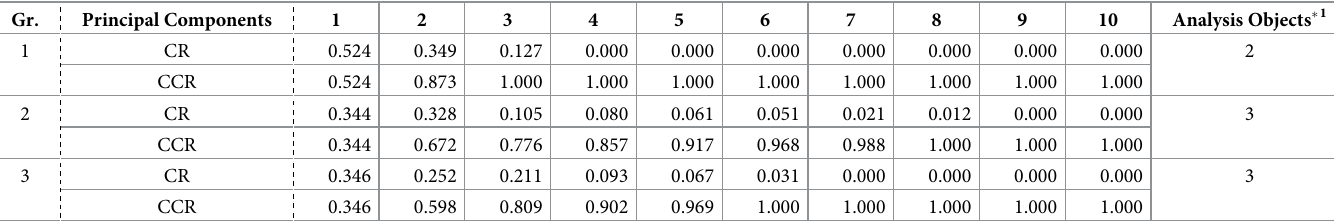
Table 4. Contribution of big data to the principal component analysis of connections between research fields (2018). Gr. Principal